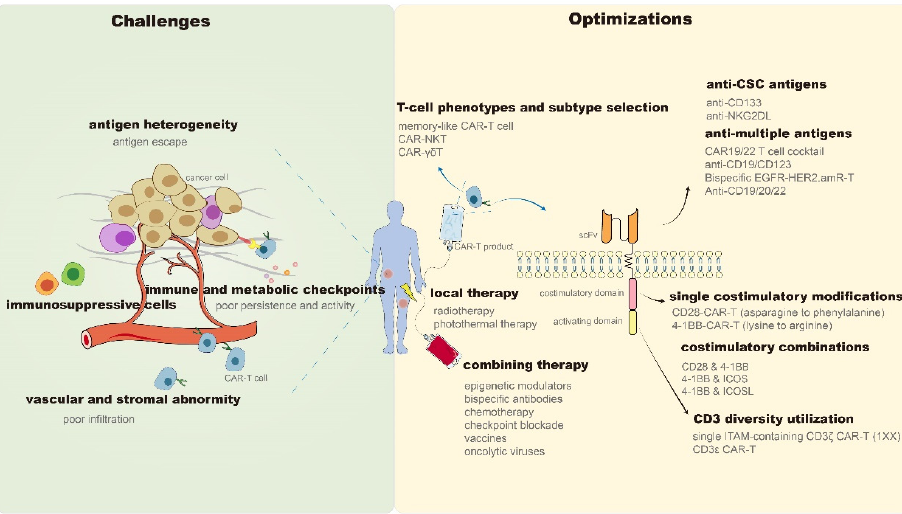
Figure 1. Challenges and optimizations of CAR-T persistence and antitumor properties. CAR—Chimeric antigen receptor; NKT—Natural killer T; γδ T—gamma delta T; CSC—Cancer stem cells; CD—Cluster of differentiation; NKG2DL—Natural killer group 2 member D ligand; EGFR—Epidermal growth factor receptor; HER2—Human epidermal growth factor receptor 2; amR—Antibody mimic receptor; scFv—Single-chain variable fragment; 4-1BB (TNFRSF9)—Tumor necrosis factor receptor superfamily 9; ICOS—Combining inducible costimulatory; ICOSL—Combining inducible costimulatory ligand; ITAM—Immunoreceptor tyrosine-based activation motif.